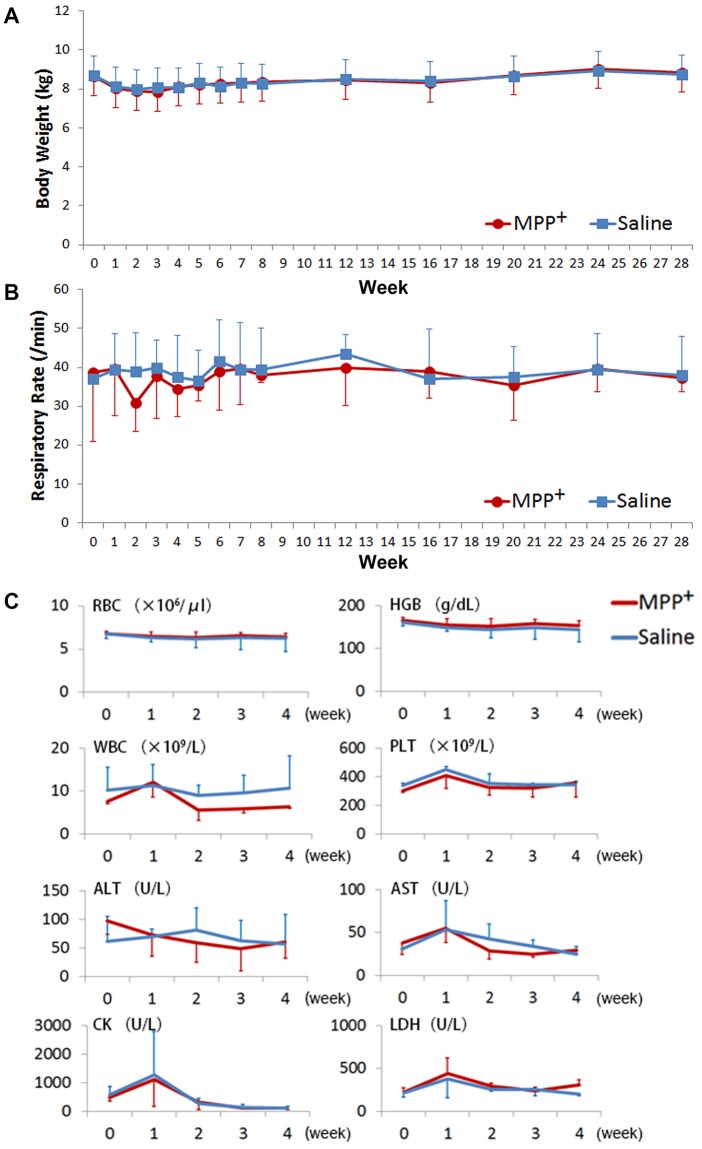
Body weight, respiratory rate, and venous blood test in the monkeys.No trend or significant differences of body weight and respiratory rate were revealed in and between MPP+ (N = 3) and control monkeys (N = 2) during the 28 week period. No trend difference between MPP+ (N = 3) and control monkeys (N = 2) were found in the blood samples [week×MPP+ interaction effect, P values for each count in parentheses: RBC (0.95), WBC (0.37), PLT (0.76), HGB (0.91), ALT (0.45), AST (0.51), CK (0.90), LDH (0.63); MPP+ main effect, P values for each count in parentheses: RBC (0.86), WBC (0.38), PLT (0.61), HGB (0.62), ALT (0.96), AST (0.75), CK (0.84), LDH (0.50)]. WBC, PLT, AST, CK, and LDH had a transient increase about a week after the operation, due to the operational damage to the surrounding tissues in both control and MPP+ infused monkeys.